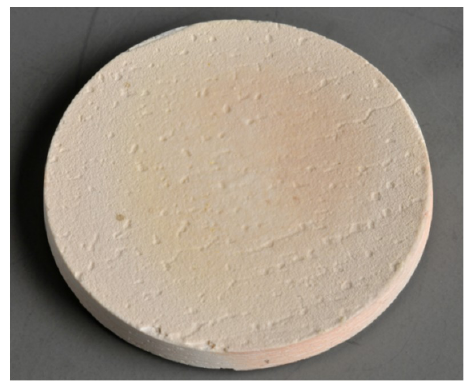
Figure 11. Photograph of VLPPS YAlO 3 coating on FW 12 after 274 cycles in CMAS test rig.